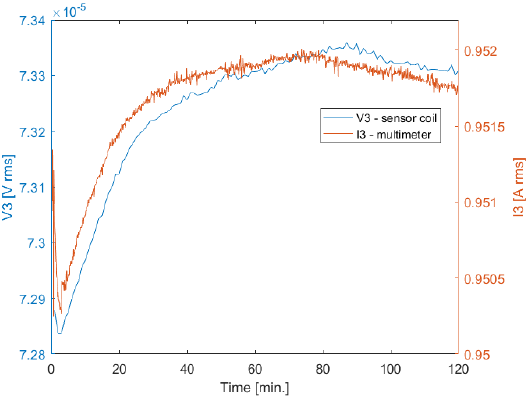
Figure 3. Voltage drift vs time; current loop turned on.